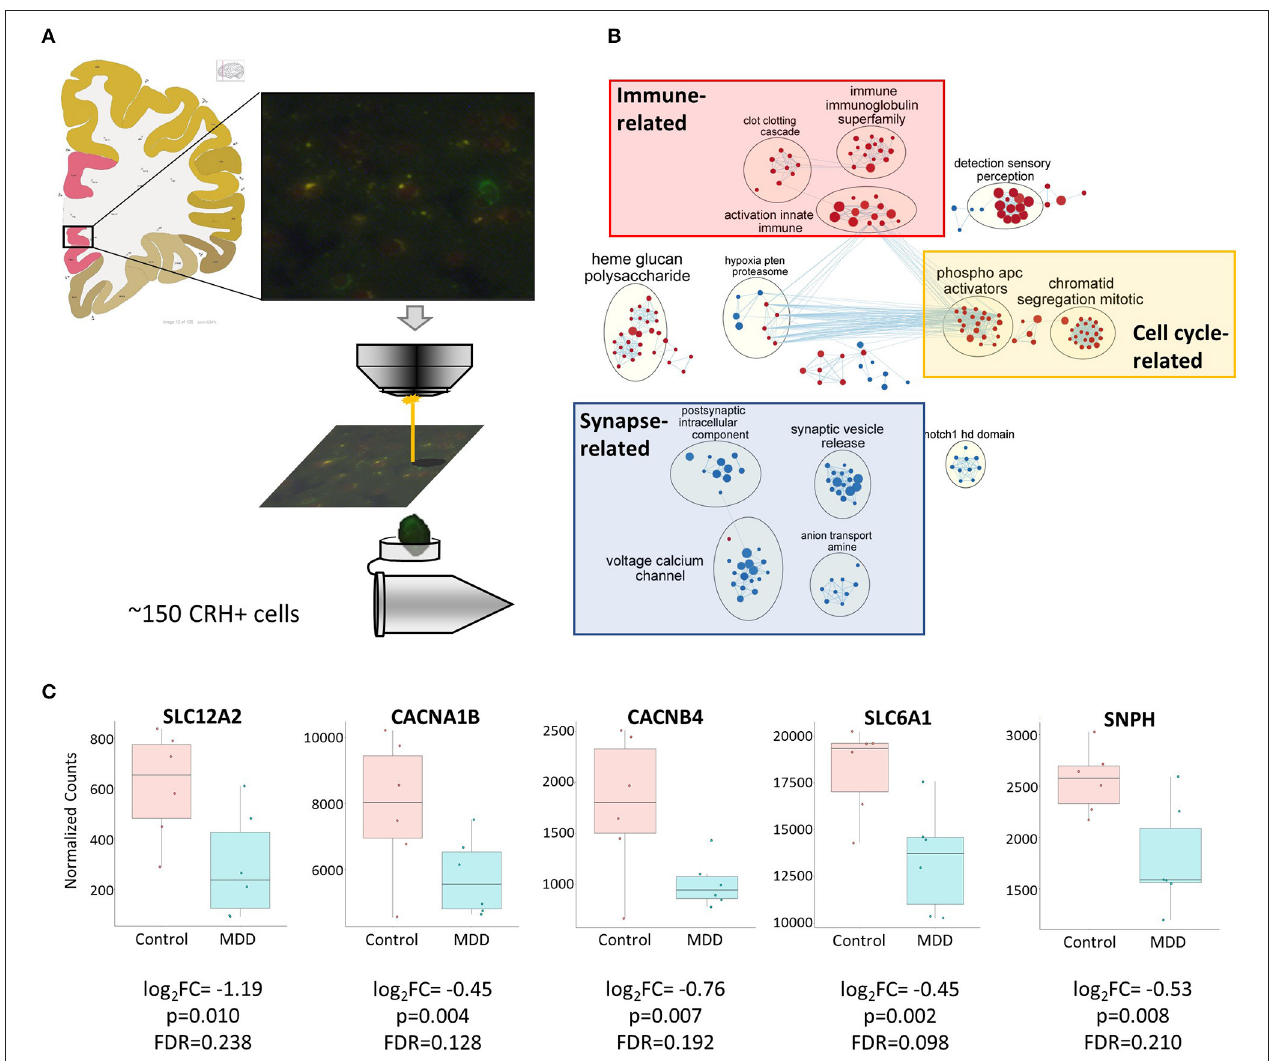
FIGURE 3 | Biological functions associated with altered CRH + GABAergic interneurons in MDD. (A) Scheme depicting CRH + interneuron collection from human sgACC using laser capture microdissection. Image credit: Allen institute for brain science [https://atlas.brain-map.org/atlas?atlas=138322605#atlas=138322605& plate=102291577]. (B) Cell type-specific transcriptomic analysis revealed reduced synaptic function- and increased cell cycle-, immune-related function in sgACC CRH + neurons of MDD patients (red: upregulated gene sets, blue: downregulated gene sets). (C) Reduced expression of synaptic related genes in the CRH + neurons in the sgACC of MDD